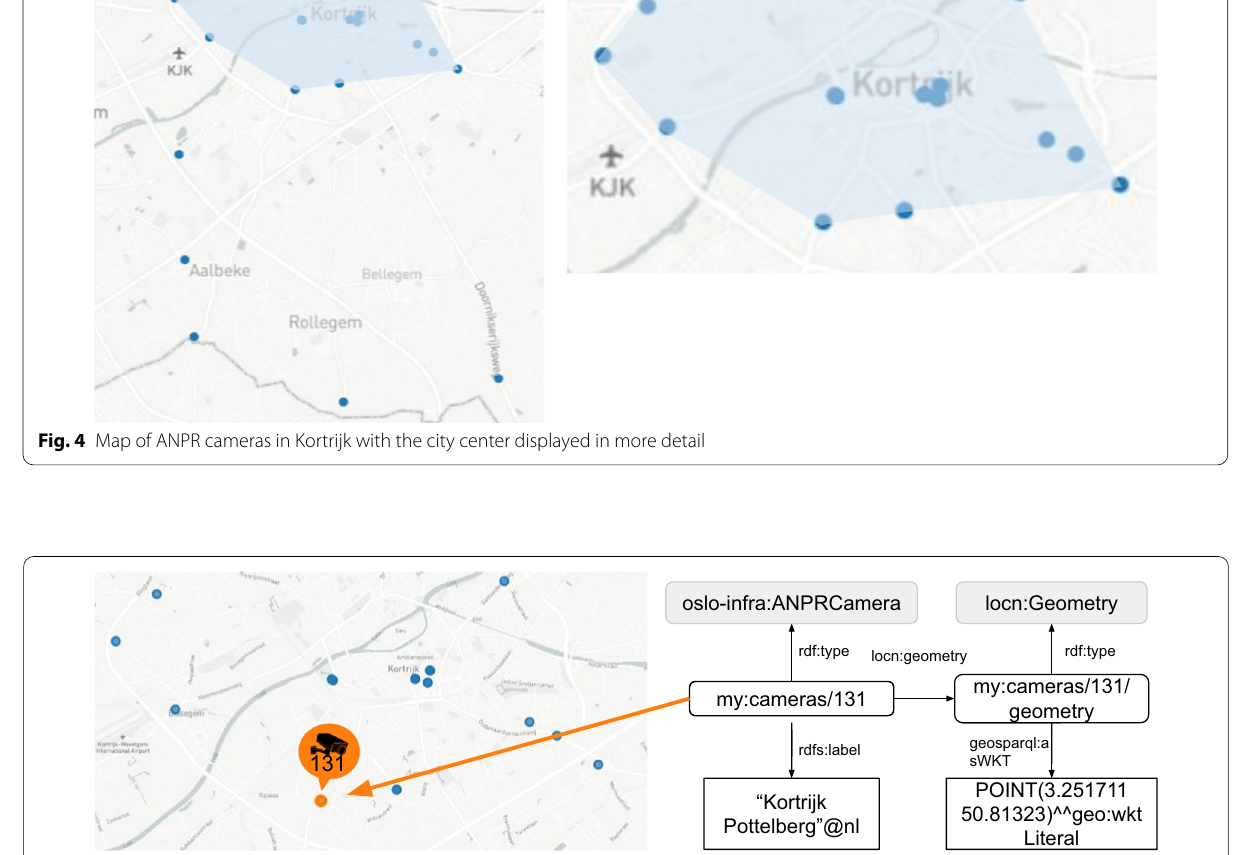
using the Well-known text (WKT) format for geometry.